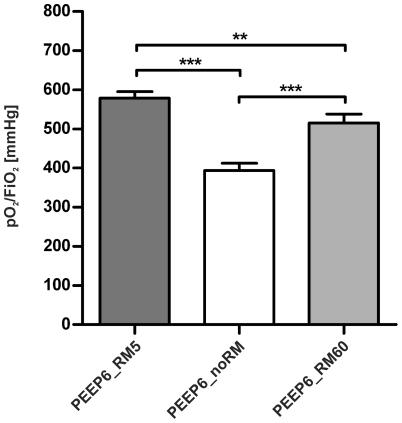
Oxygenation with 6 cmH2O PEEP.Arterial blood was analysed after six hours of ventilation and the pO2/FiO2 ratio was calculated. (n = 4 in all groups). ** p<0.01, *** p<0.001.